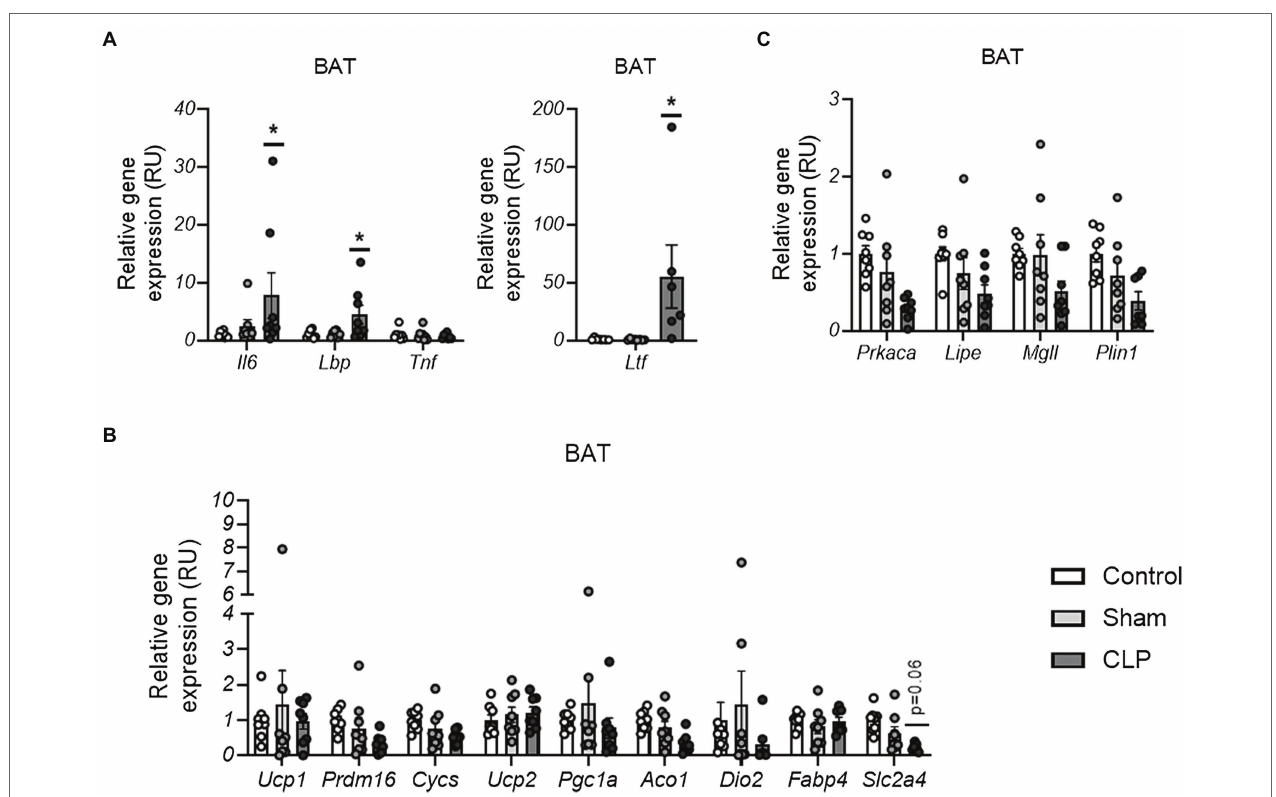
FIGURE 3 | (A–C) The effects of CLP-induced sepsis on expression of inflammation (A) , thermogenesis/mitochondria (B) , and lipolysis (C) -related genes in BAT, . CLP: cecal ligation and puncture. * p < 0.05 and ** p < 0.01 compared to sham, n = 7–8 mice per